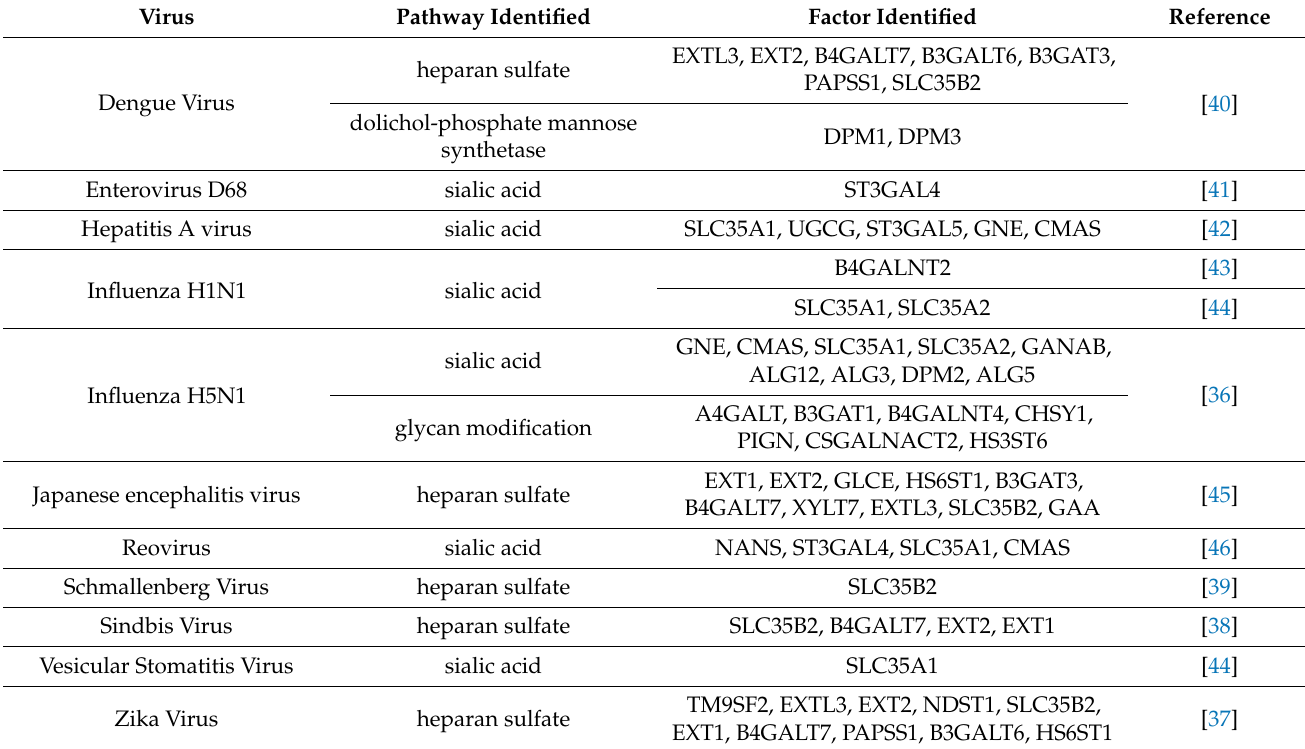
Table 2. Glycan biosynthetic pathways identified with CRISPR/Cas9 screening.